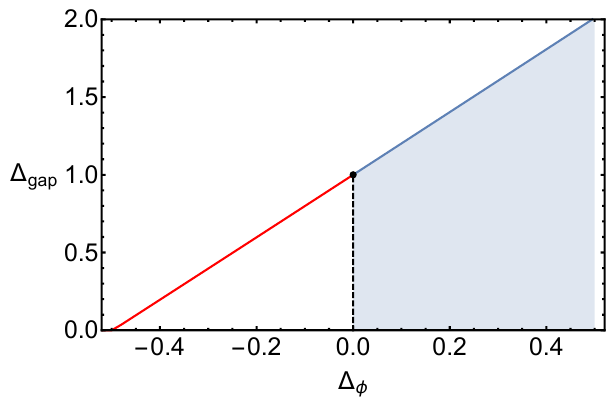
Figure 8 . Flowing into a non-unitary region with N = 100 components. Below (cid:1) (cid:30) = 0 the extremal solution develops a negative OPE coe(cid:14)cient. However, there is still an associated positive linear functional. The functional does set a bound on possible unitary solutions in this region, but this bound may not be